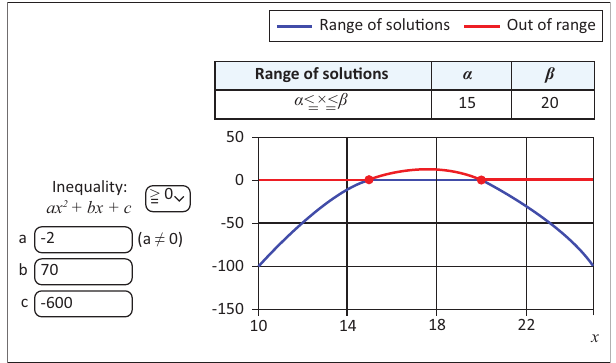
FIGURE 1: Visualisation of solution set for Q1 generated using a graphing calculator.